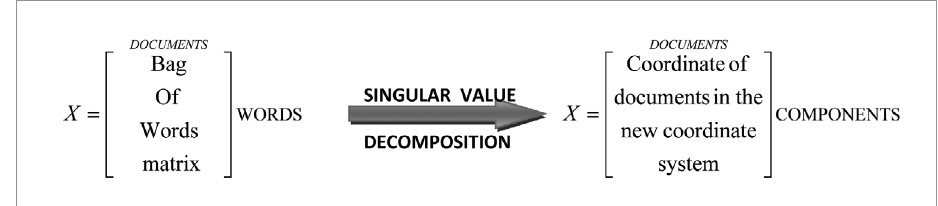
Fig. 4. BOW matrix and the method of SVD